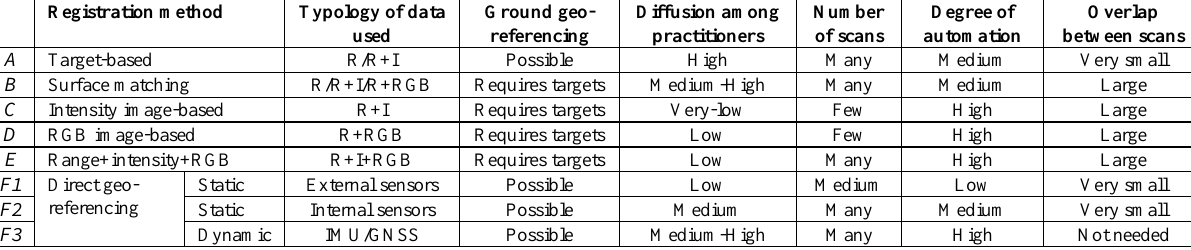
Table 1. Different categories of scan registration techniques with related characteristics; acronyms in the column ‘Typology of data used’ mean: R=range data, I=intensity data, RGB=color